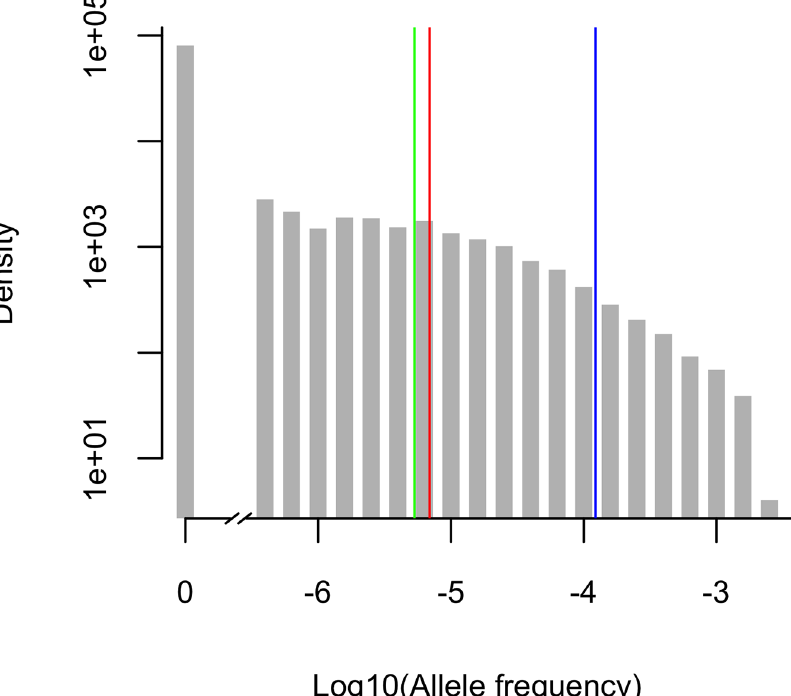
Fig 1. Expected allele frequencies in a population, according to mutation-selection balance models. The blue bar denotesthe expectedallelefrequency under an infinite population size, the green bar the mean under a finite constant population,and the red bar the mean under a plausibledemographic model for Europeanpopulations; for this last case, the entire distributionacross 100,000simulations is shown in the grey histogram. All models assume s = 1 and h = 0, i.e., fully recessive, lethalmutations. For the finite constant population size model, we present the mean frequencyfor a populationsize of 20,000 (see S2A Fig for other choices). Population allele frequencies ( q ) were transformed to log10( q ),and those q = 0 were set to 10 − 7 for visual purposes, but indicatedas “0” on the X-axis. The density of the distribution is plotted on a log- scale on the Y-axis. The mutation rate u was set to 1.5 x 10 − 8 per bp per generationin all models.